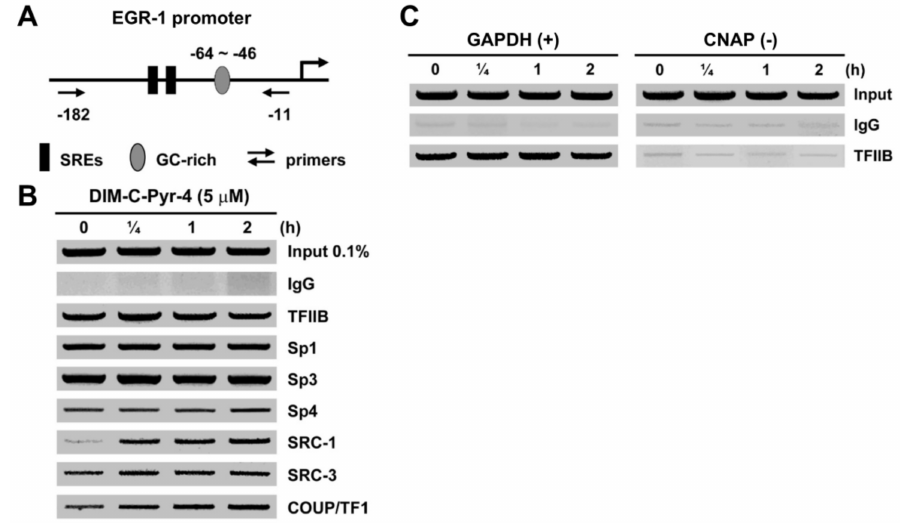
Figure 8. Chromatin immunoprecipitation assay. ( A ) Egr-1 promoter and positioning of PCR primers. ( B ) Chromatin immunoprecipitation (ChIP) assay of Egr-1 promoter. MCF-7 cells were treated with 5 µ M DIM-C-Pyr-4 for 0, 0.25, 1.0, and 2.0 h, and cells were harvested and analyzed in a ChIP assay